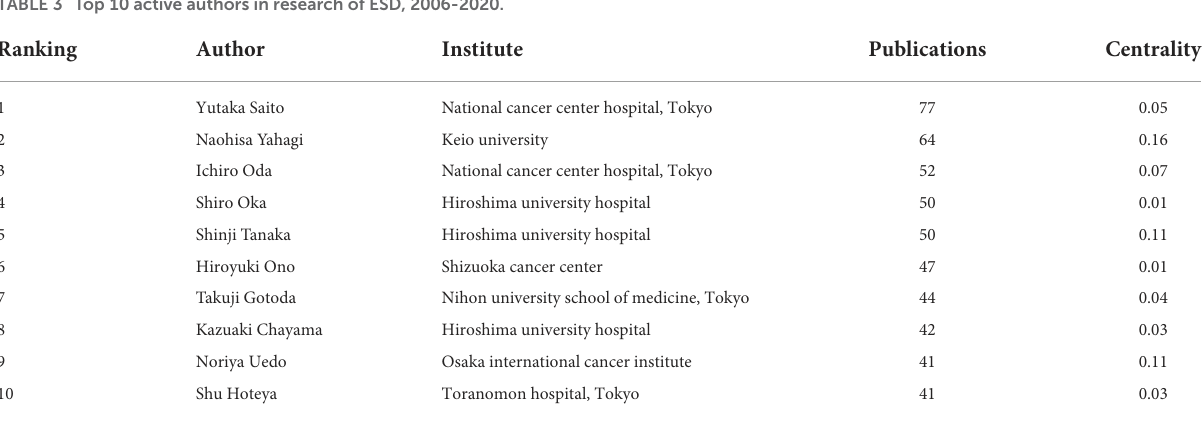
TABLE 3 Top 10 active authors in research of ESD,